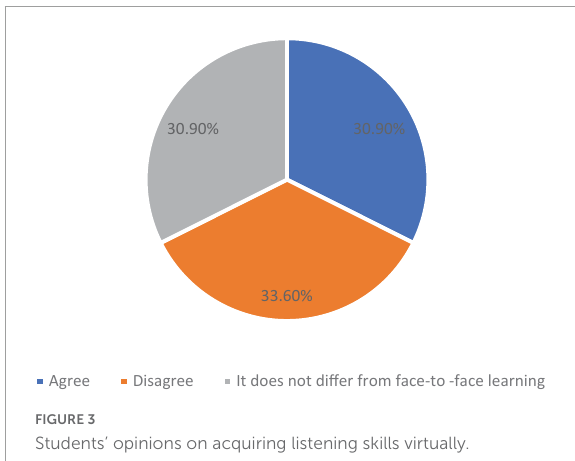
FIGURE4 Students’ opinions on learning speaking skills